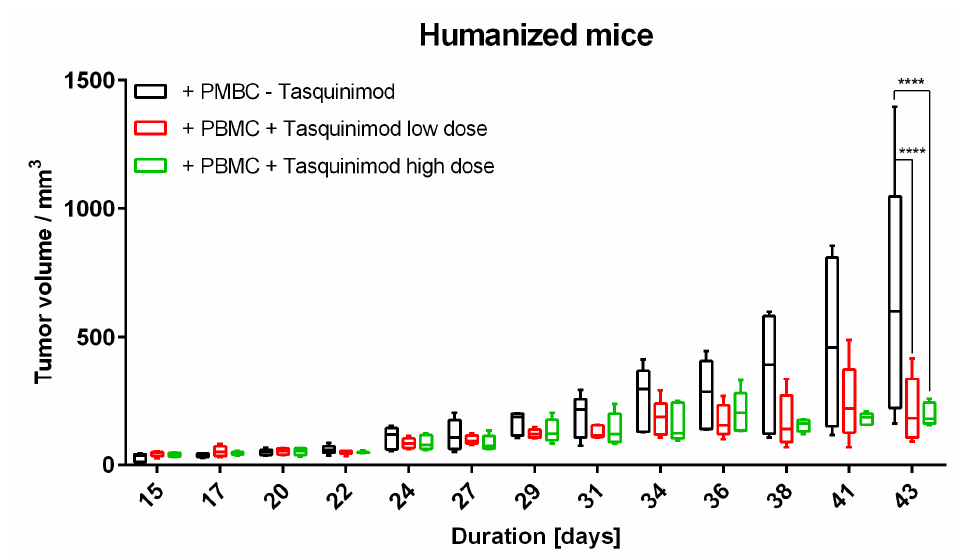
Figure 6. Tumor growth of Ma-Mel-19 cells in humanized mice under treatment with Tasquinimod (high: 5 mg/kg body weight and low: 1 mg/kg body weight). Mice were humanized on day 23. Tasquinimod was applied on day 24, 31, and 37. Data are shown as box plots with whiskers at min/max. **** p < 0.0001; Statistical significance was determined using the Tukey’s multiple comparison test. Five animals per group.